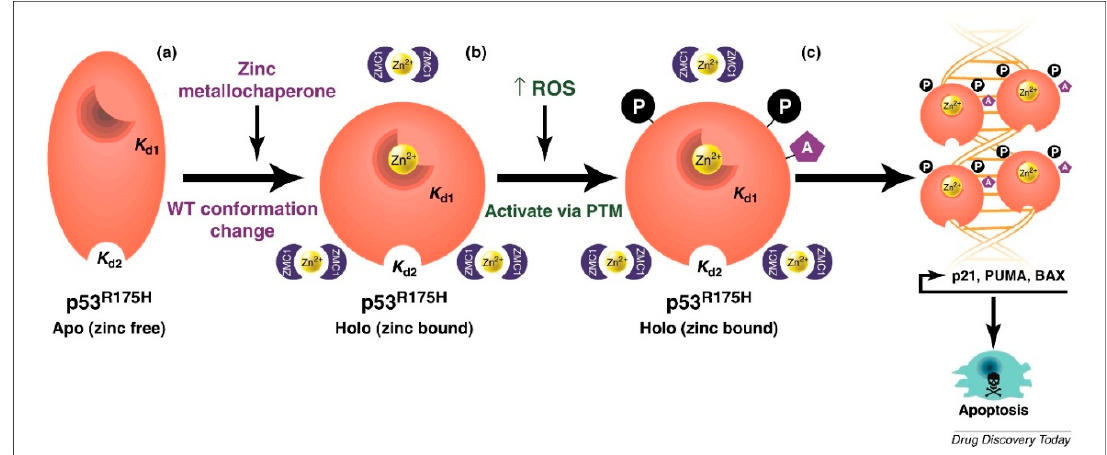
Figure 1. Model of the ZMC1 dual mechanism. ( a ) The p53 R175H is misfolded owing to impaired zinc binding (apo form) and, as a result, no site-specific DNA binding occurs (and no transcription of p53 targets). ZMC1 functions as a zinc metallochaperone (ZMC) by providing a source of zinc to facilitate refolding of the p53 R175H to a WT-like structure (holo form). ( b ) ZMC1 boosts reactive oxygen species (ROS) levels, which activates a stress response (i.e., ATM) that transactivates the p53 R175H through amino-terminal phosphorylation (P) and acetylation (A) events. ( c ) The newly conformed and transactivated p53 R175H can now bind DNA in a site-specific manner, causing transcription of apoptotic effectors that leads to tumor cell death. K d1 = K d of the native binding site, K d2 = K d of the non-native binding site.